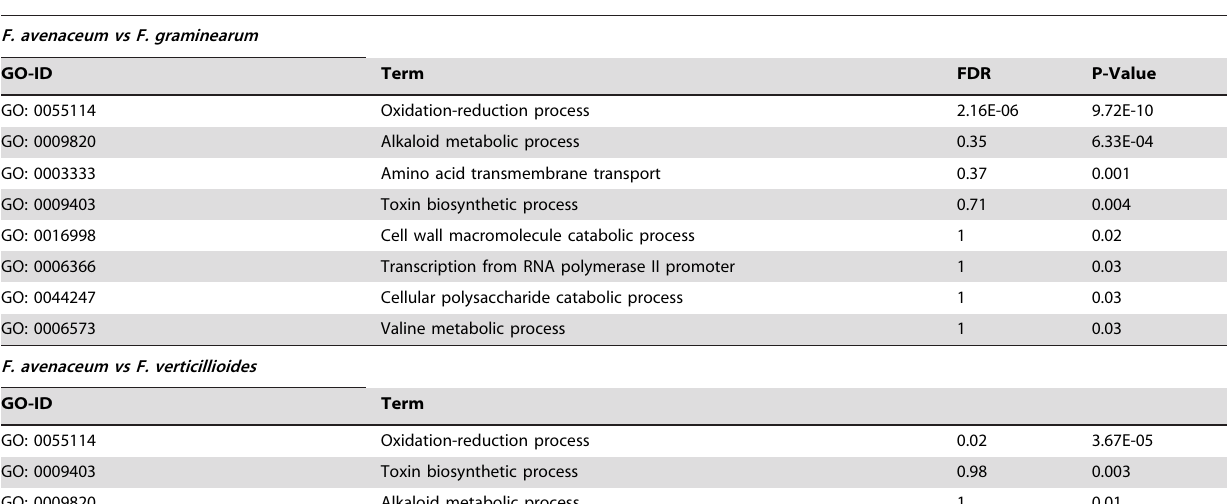
Table 3. Enriched biological processes in Fa05001 proteins without orthologs in other genome sequenced Fusaria (P , 0.05).